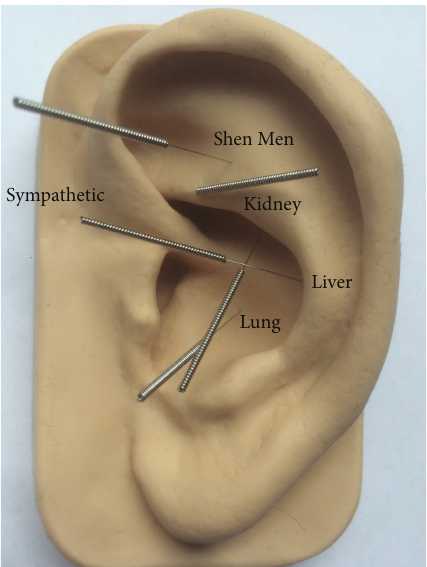
Figure 1: Acupuncture points according to the NADA protocol: Shen Men, sympathetic, kidney, liver, and